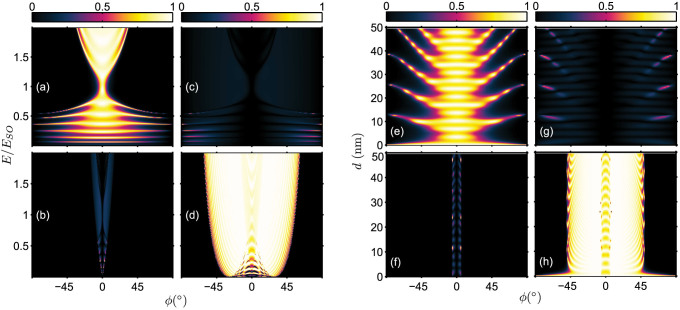
Energy spectrum and the barrier width dependence of the transmission probabilities in the absence of interface scattering potentials.Energy dependence of (a) ; (b) ; (c) ; and (d) . Barrier width dependence of (e) ; (f) ; (g) ; and (h) . The tunneling junction parameters are V0 = ESO and kSO = 1.3 × 109 m−1. For (a)–(d), d = 20 nm and for (e)–(h), E = 0.5ESO.